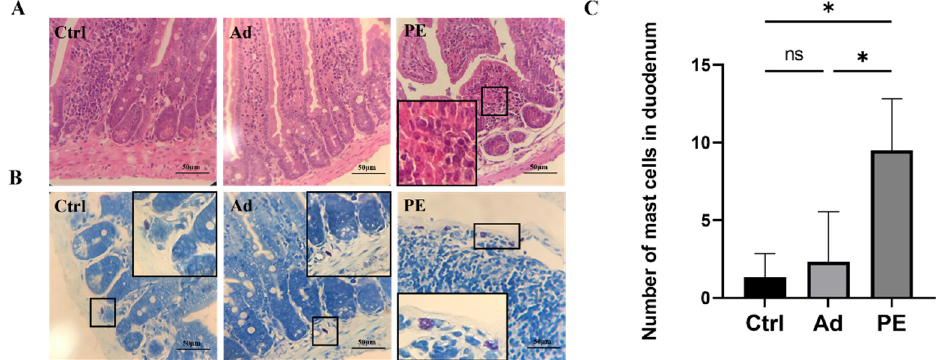
Figure 4. The representative photomicrographs of duodenal tissue in mice ( n = 4/group). ( A ) H&E- stained duodenal tissue; magnifications, ×400. ( B ) Toluidine blue-stained duodenal tissue; magnifi- cations, ×400. ( C ) The number of mast cells in the duodenum. ns: no significance; *: p < 0.05.